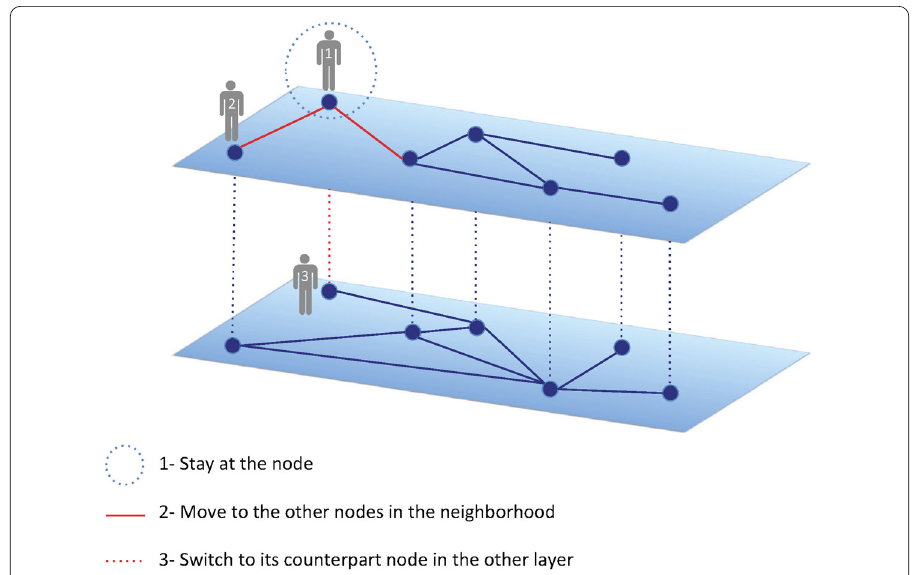
Figure 2 Random walk on a multiplex. An illustration of different possible moves available for a random walker in a multiplex